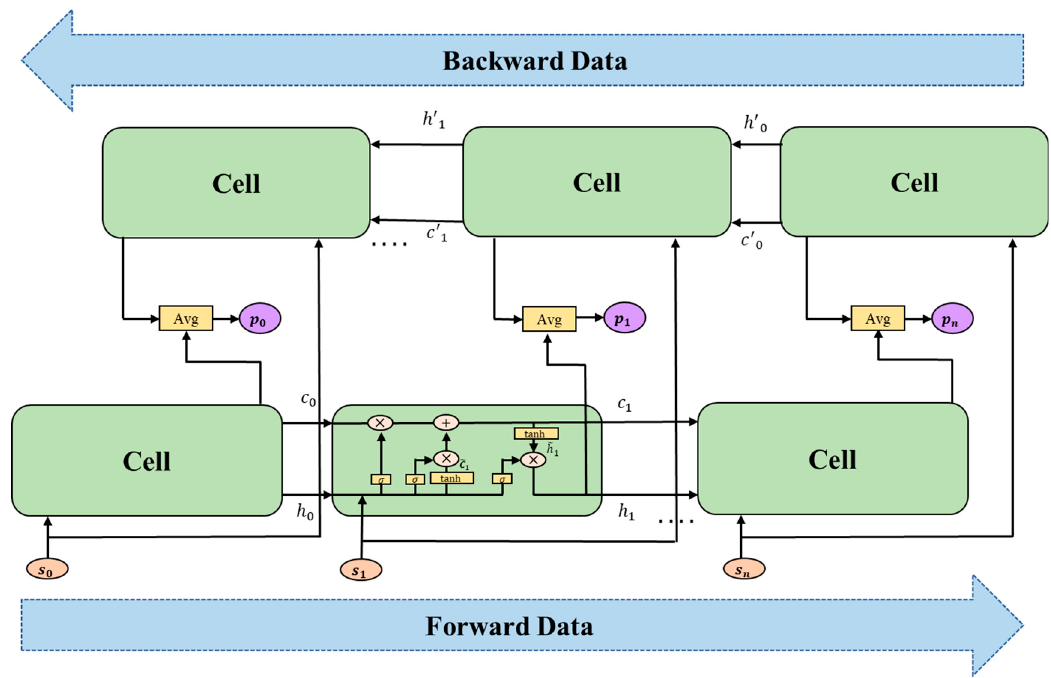
Figure 5. BLSTM architecture.